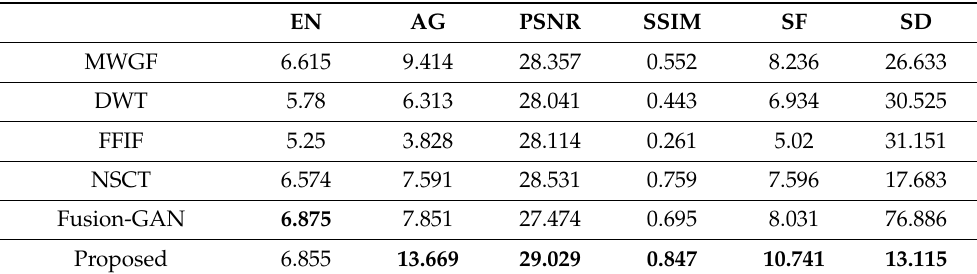
Table 3. Group1 objective evaluation result.